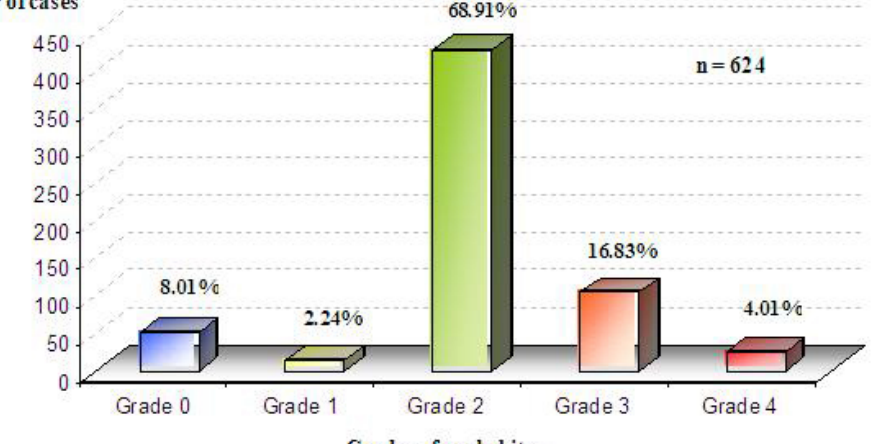
Figure 6. Distribution of snakebites by clinical